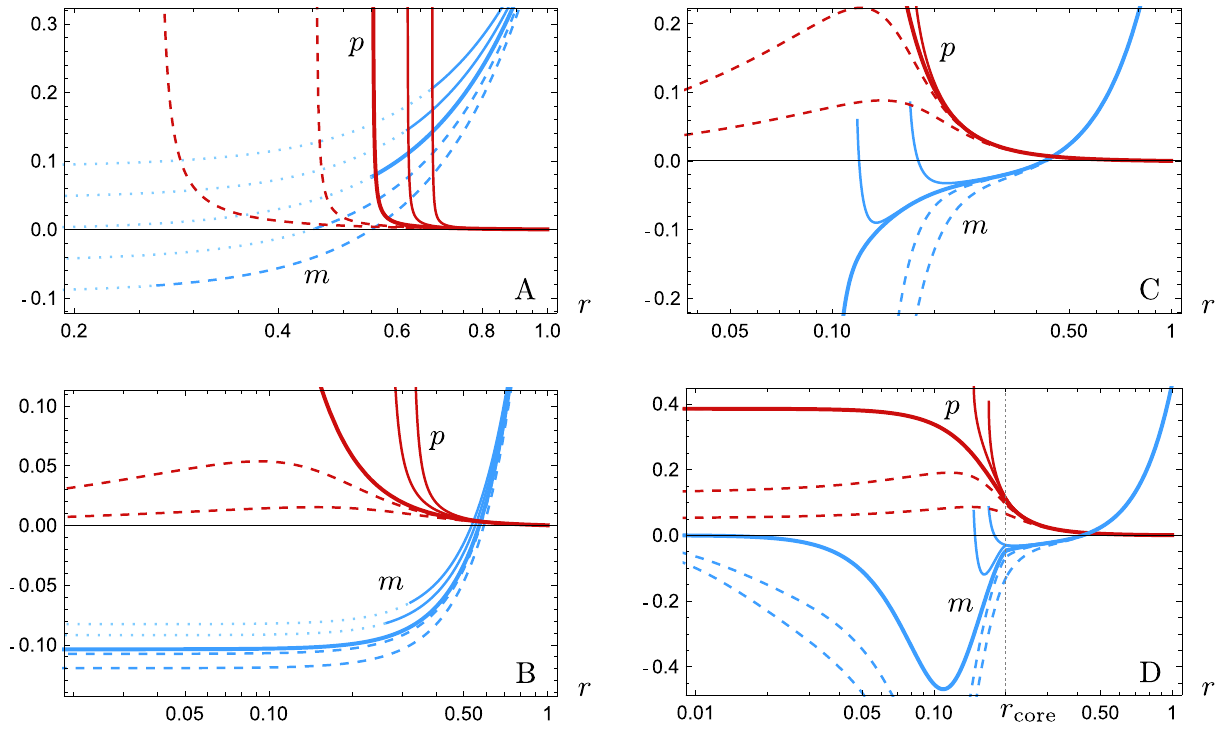
Figure 2. Plots of the pressure (red) and Misner-Sharp mass (blue) of solutions surrounding: ( A ) the classical critical solution with ρ = ρ c ; ( B ) the classical separatrix in pressure; ( C ) the semiclassical critical solution with , α = 1.01 ; and ( D ) a semiclassical ultracompact stellar solution with a regular core of size F ( r ) = 1 / r 2 + α l 2 P r core ≃ 0.2 . For every integration, we have chosen the values R = 1 and C R = 0.92 for visualization purposes. (cid:31) (cid:30) The values of ρ increase from right to left in the pressure profiles (e.g. thin dashed lines correspond to greater ρ than thin continuous